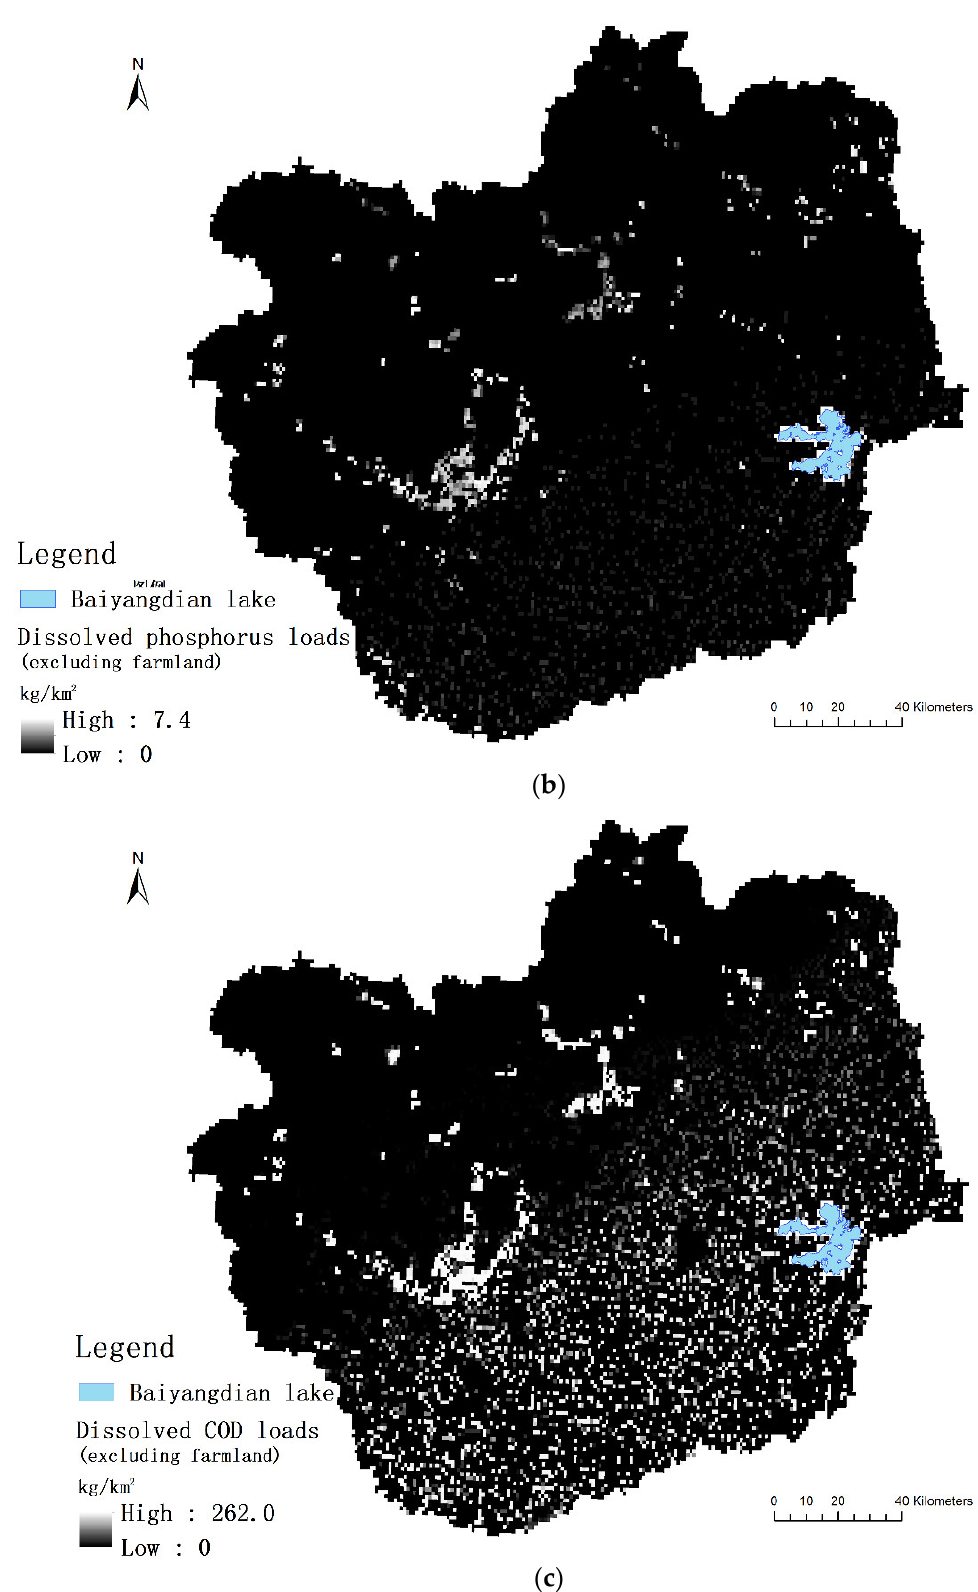
Figure 7. Dissolved pollutant load of rainfall per unit: ( a ) Total nitrogen load, ( b ) Total phosphorus load, ( c ) COD load.